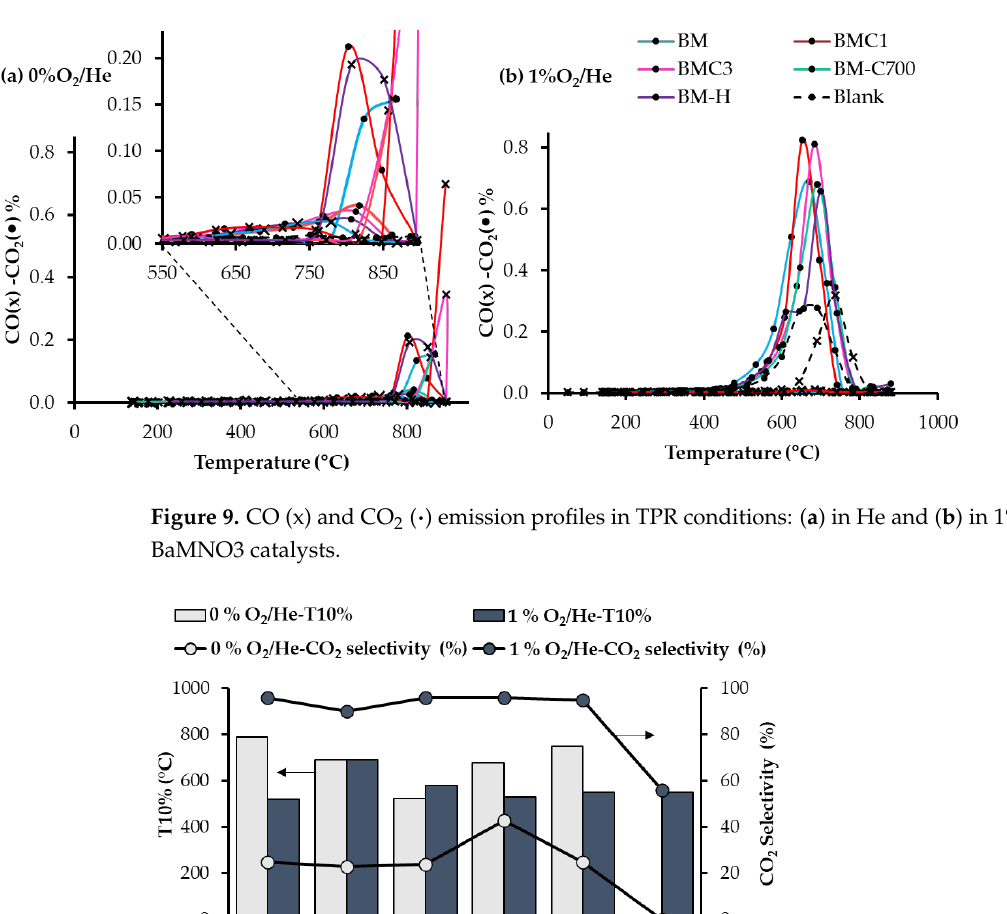
Figure 8. Soot conversion profiles in TPR conditions in ( a ) He and ( b ) 1% O 2 /He for BaMnO 3 catalyst series.